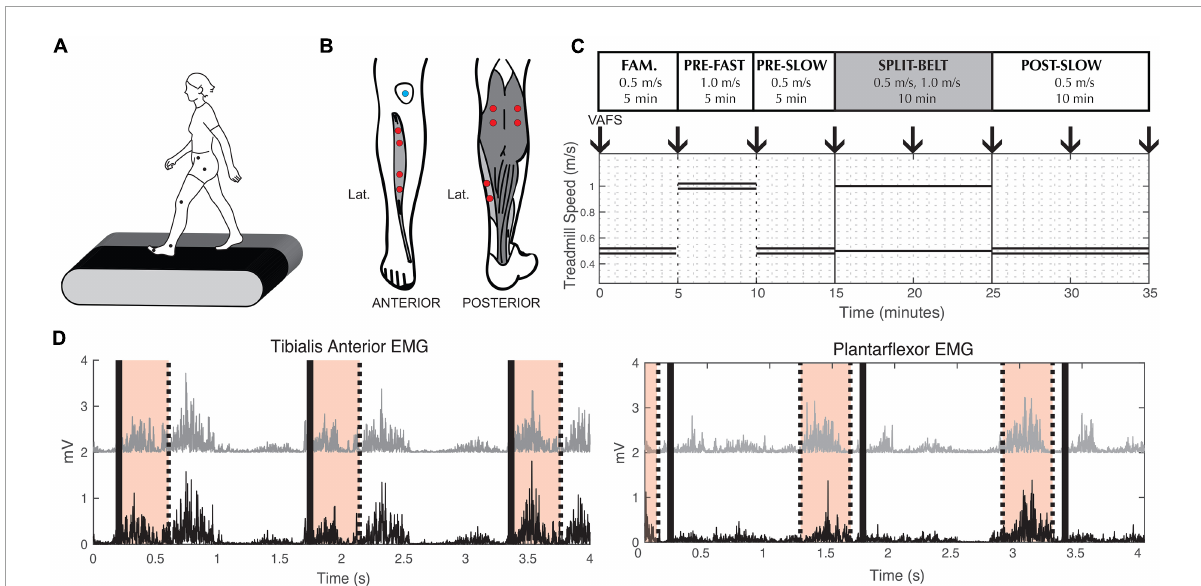
FIGURE1 Experimental methods. (A) Reflective markers used to measure lower limb kinematics. (B) Electrode placement for Electromyography measurements. (C) Split-belt treadmill walking protocol. Double lines indicate treadmill speed during tied-belt conditions. Single lines indicate the different left and right speeds during split-belt condition. Down arrows indicate when participants were asked to indicate their fatigue level (VAFS). Fam. = Familiarization. (D) Example of processed tibialis anterior and plantarflexor EMG from a representative participant. To calculate coherence during swing phase, we used EMG signals from the proximal (black) and distal (gray) muscle belly of the tibialis anterior 0–400 ms (shaded area) after toe-off (thick black lines). To calculate coherence during stance phase, we used EMG signals from the medial gastrocnemius (black) and soleus (gray) muscle 500–100 ms (shaded area) before toe-off (thick black